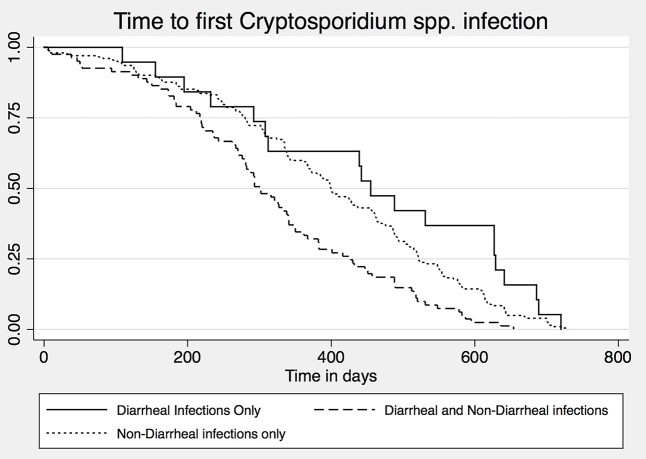
Kaplan Meier curve of the 302 children infected with Cryptosporidium spp. categorized by type of infection experienced (diarrheal, non-diarrheal, or both).There was no significant difference between timing of first asymptomatic versus symptomatic Cryptosporidium infection (HR 0.68, 95% CI 0.42, 1.09, p = 0.11). However, children who went on to develop both symptomatic and asymptomatic infection did get infected earlier in life (HR = 1.74, 95% CI 1.34, 2.27, p < 0.0001).